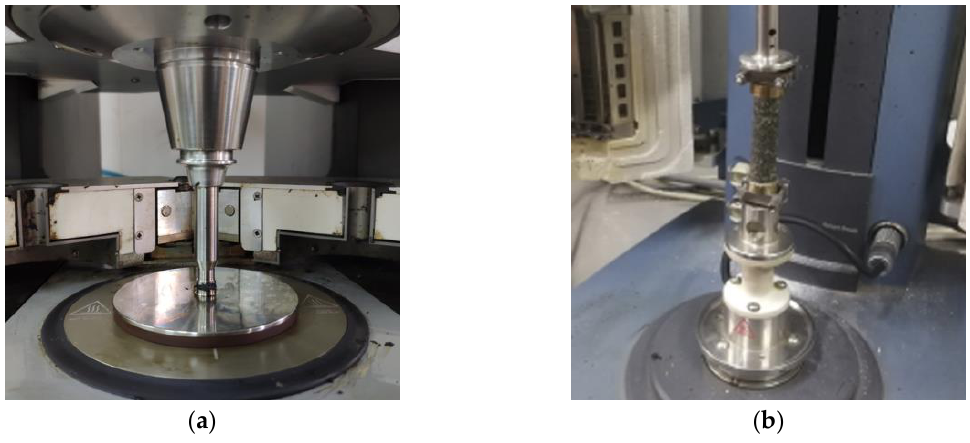
Figure 1. Fatigue characterizing tests: ( a ) G*sinδ and linear amplitude sweep (LAS) test for binders; ( b ) shear fatigue test for mortars.